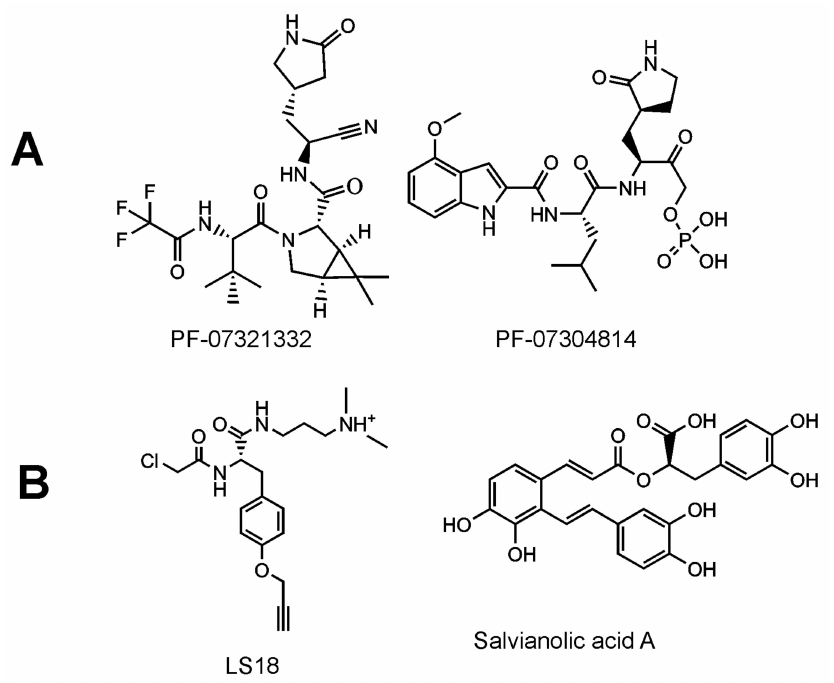
Figure 9. Inhibitors of SARS-CoV-2 Mpro in clinical trials ( A ) and inhibitors of the Mpro precursor ( B